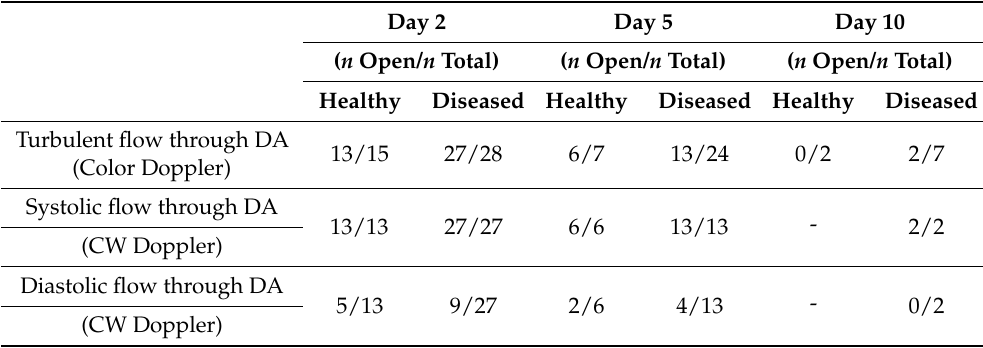
Table 2. Echocardiographic visualization of the ductus arteriosus (DA) from the left parasternal long-axis view of the pulmonary artery in healthy and diseased foals on days 2, 5 and 10. CW: continuous wave Doppler.